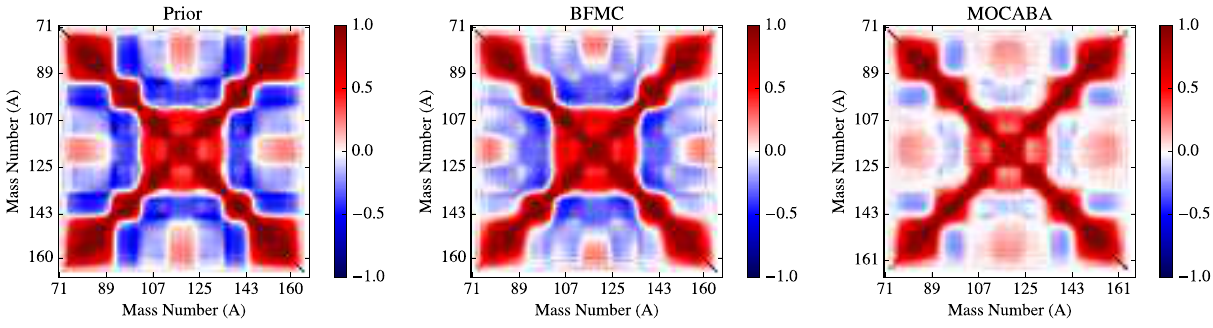
Fig. 8. Correlations between independent FYs of